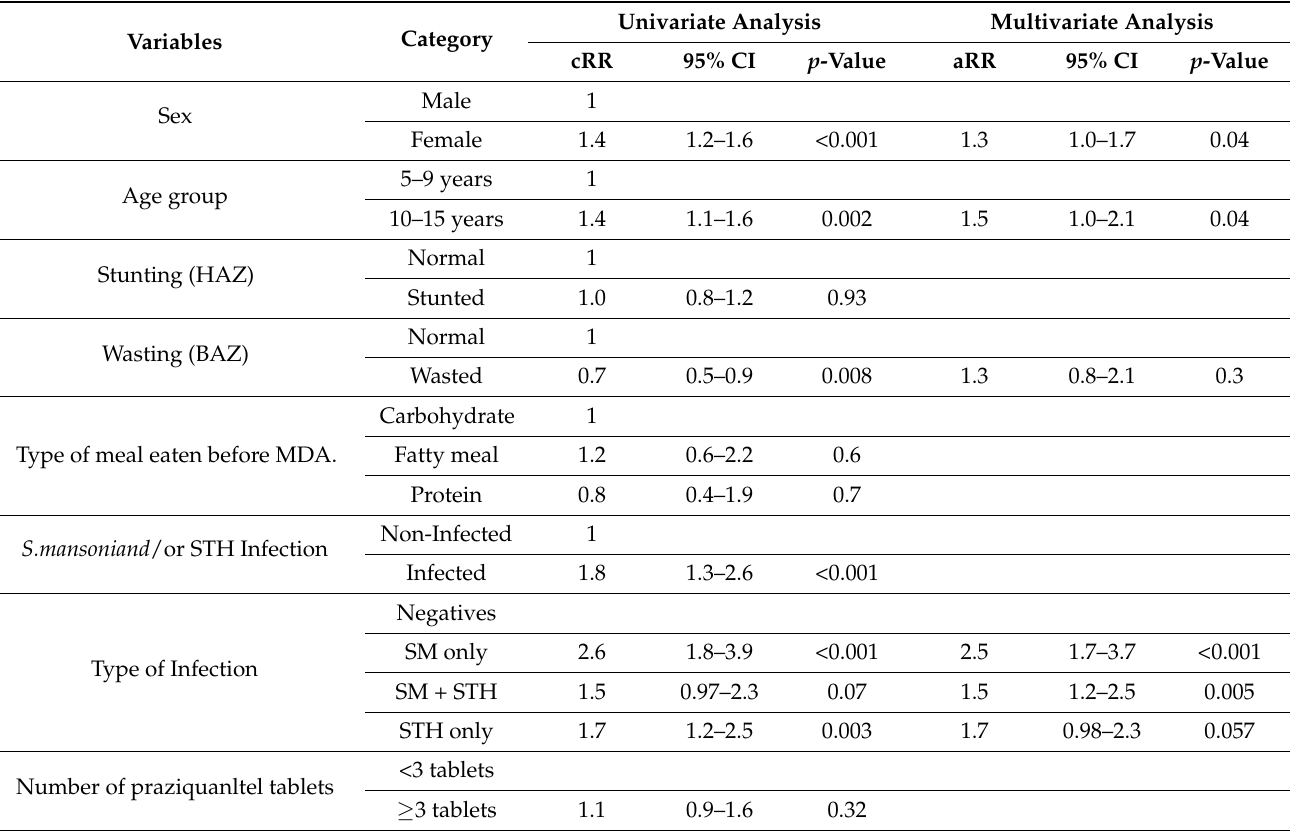
Table 4. Predictors of AEs following mass praziquantel and albendazole administration for school